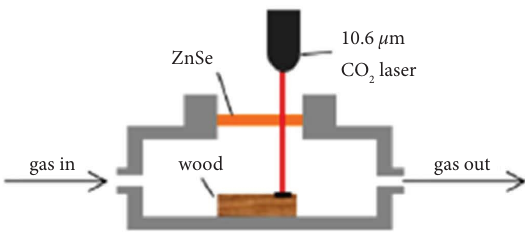
Figure 17: LIG synthesis on wood